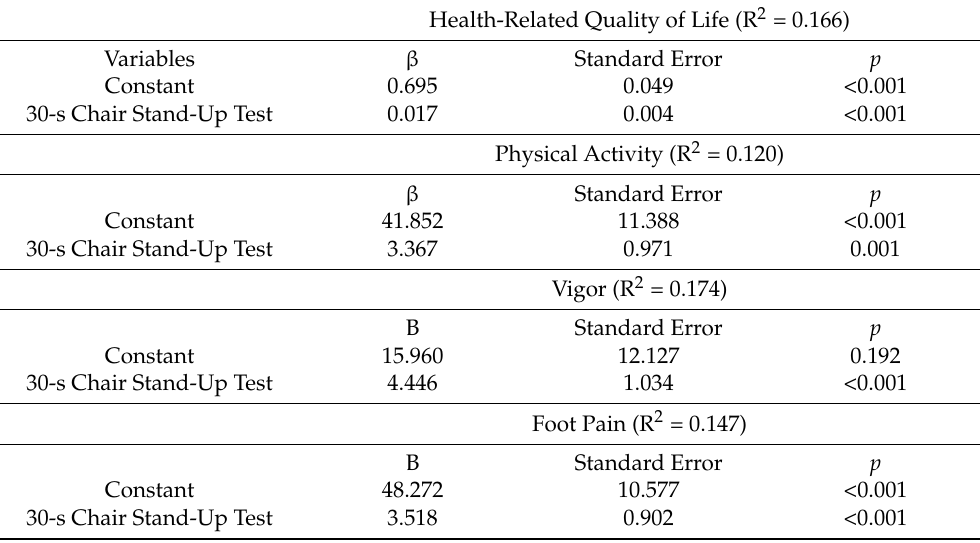
Table 4. Linear regression model explaining health-related quality of life and the dimensions physical activity, vigor, and foot pain of the FHSQ questionnaire ( n =